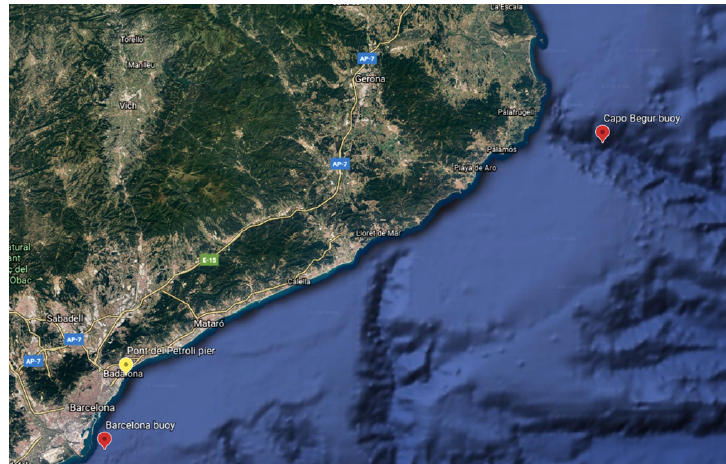
Figure 4. View of the Catalan coast between Barcelona and Capo Begur. (Map Data: Google Earth, SIO, NOAA, U.S. Navy, NGA, GEBCO).